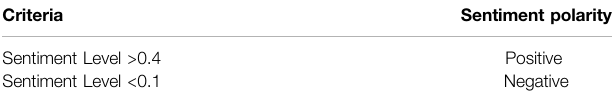
TABLE 1 | Criteria for sentiment level.